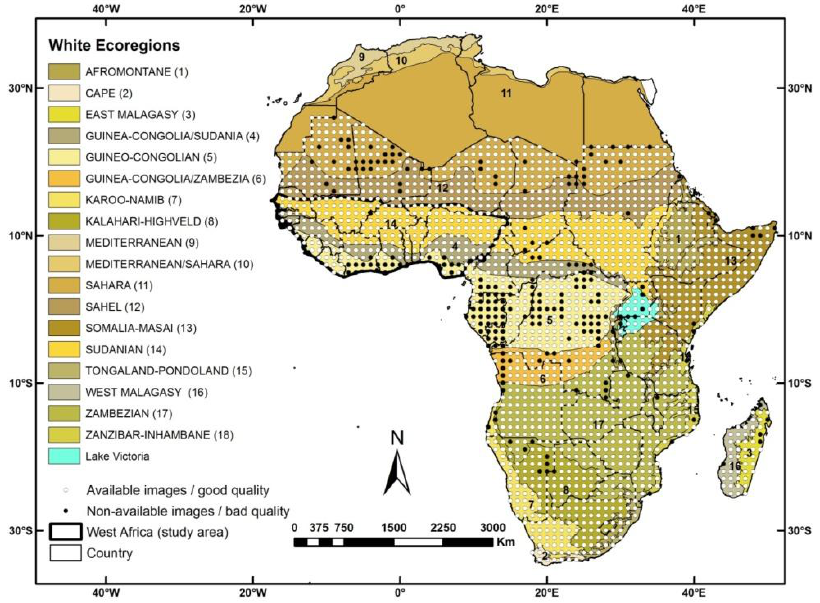
Figure 2. Availability of good quality Landsat MSS images for the 1975 reference year over sub-Saharan Africa (including our study area over West Africa) overlaid on White’s ecoregions